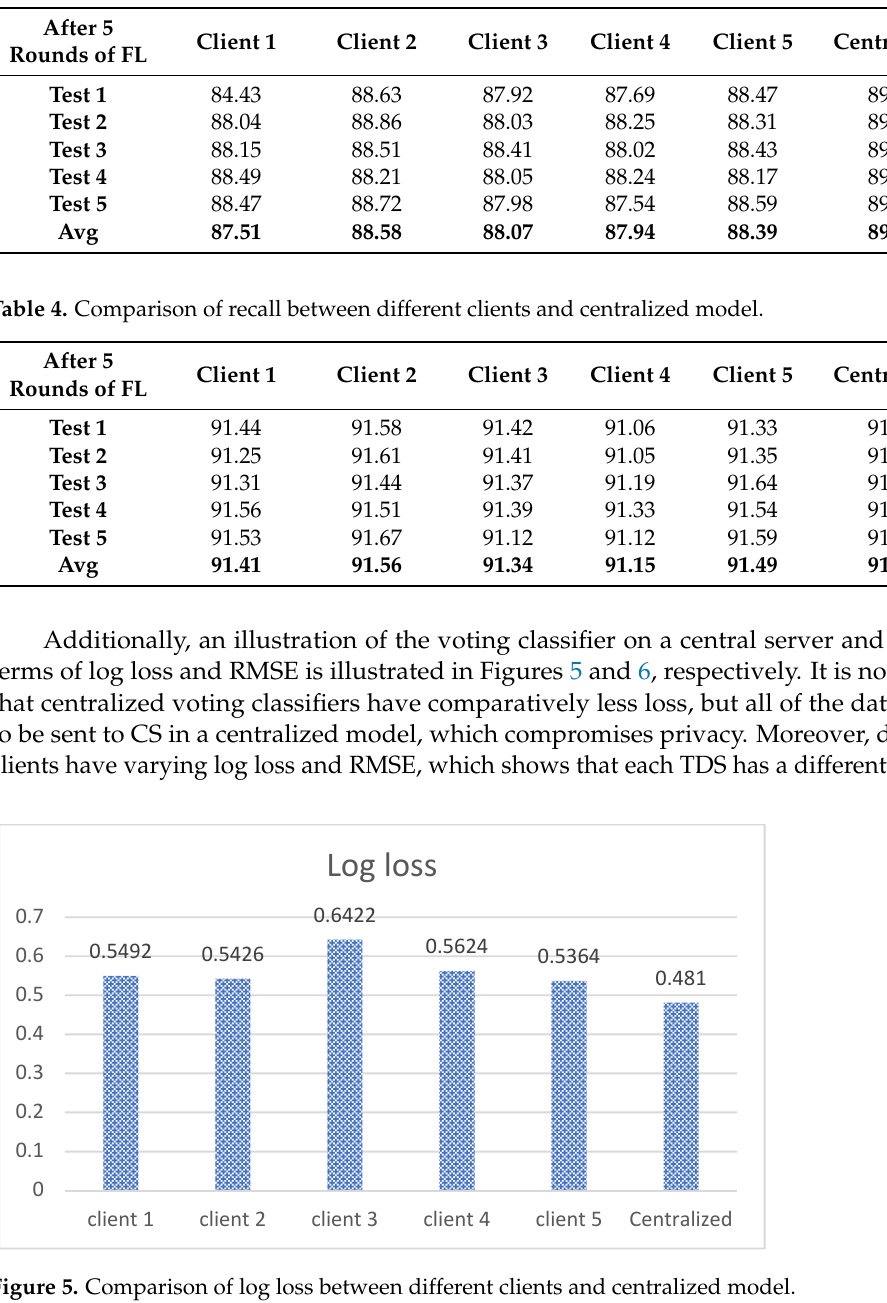
Table 3. Comparison of f_measure between different clients and centralized model.